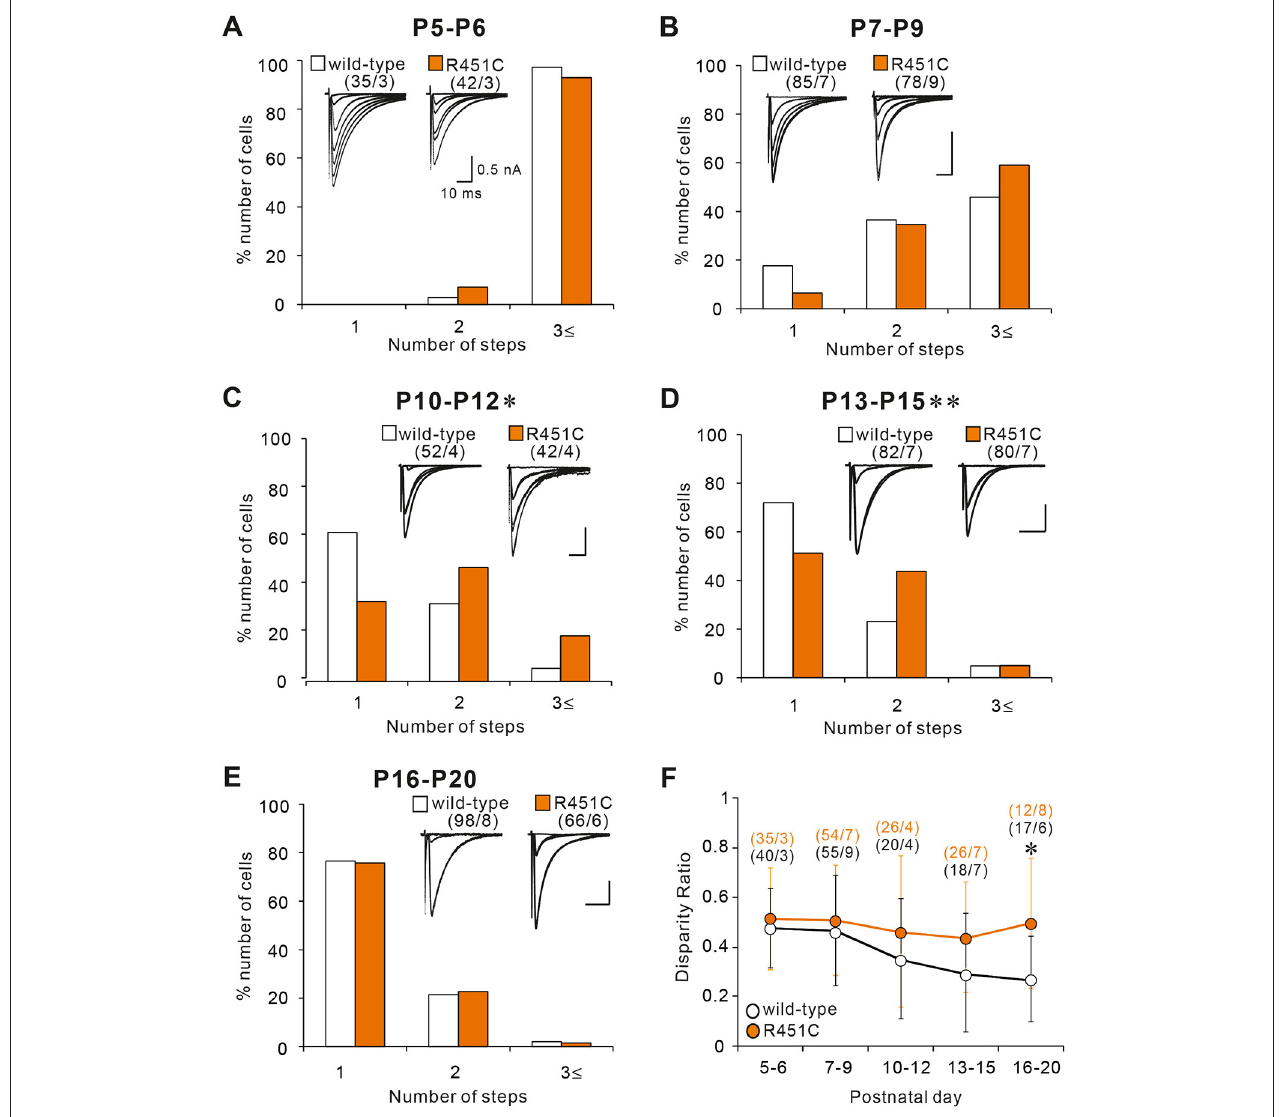
FIGURE 2 | The NLGN3-R451C mutation impairs CF synapse elimination during postnatal development. (A–E) Specimen records of CF-EPSCs (inserts, five to eight traces were superimposed at each threshold intensity; Vh = − 10mV) and frequency distribution histogram for the number of discrete CF-EPSCs for wild-type (open columns) and NLGN3-R451C mutant mice (orange columns) at indicated ages. There is no significant difference in the frequency distribution in (A,B,E) between wild-type and NLGN3-R451C mutant mice [ (A) , p = 0.143, (B) , p = 0.063, and (E) , p = 0.6 by Mann-Whitney U test]. In contrast, frequency distributions for (C,D) are significantly different between wild-type and NLGN3-R451C mutant mice ( C , * p = 0.024 and D , ** p < 0.001 by Mann-Whitney U test). Scale bars, 10ms and 0.5 nA. Numbers of PCs/mice are shown in parentheses. (F) Summary plots of disparity ratio in wild-type (open circles) and NLGN3-R451C mutant (orange circles) mice at indicated ages. There is a significant difference between wild-type and NLGN3-R451C mutant mice aged P16–P20 (P5–P6, p = 0.961; P7–P9, p = 0.877; P10–P12, p = 0.409; P13–P15, p = 0.173; P16–P20; * p = 0.039 by Two-way ANOVA with Tukey’s post-hoc test). Numbers of PCs/mice are shown in parentheses. Data are expressed as mean ±